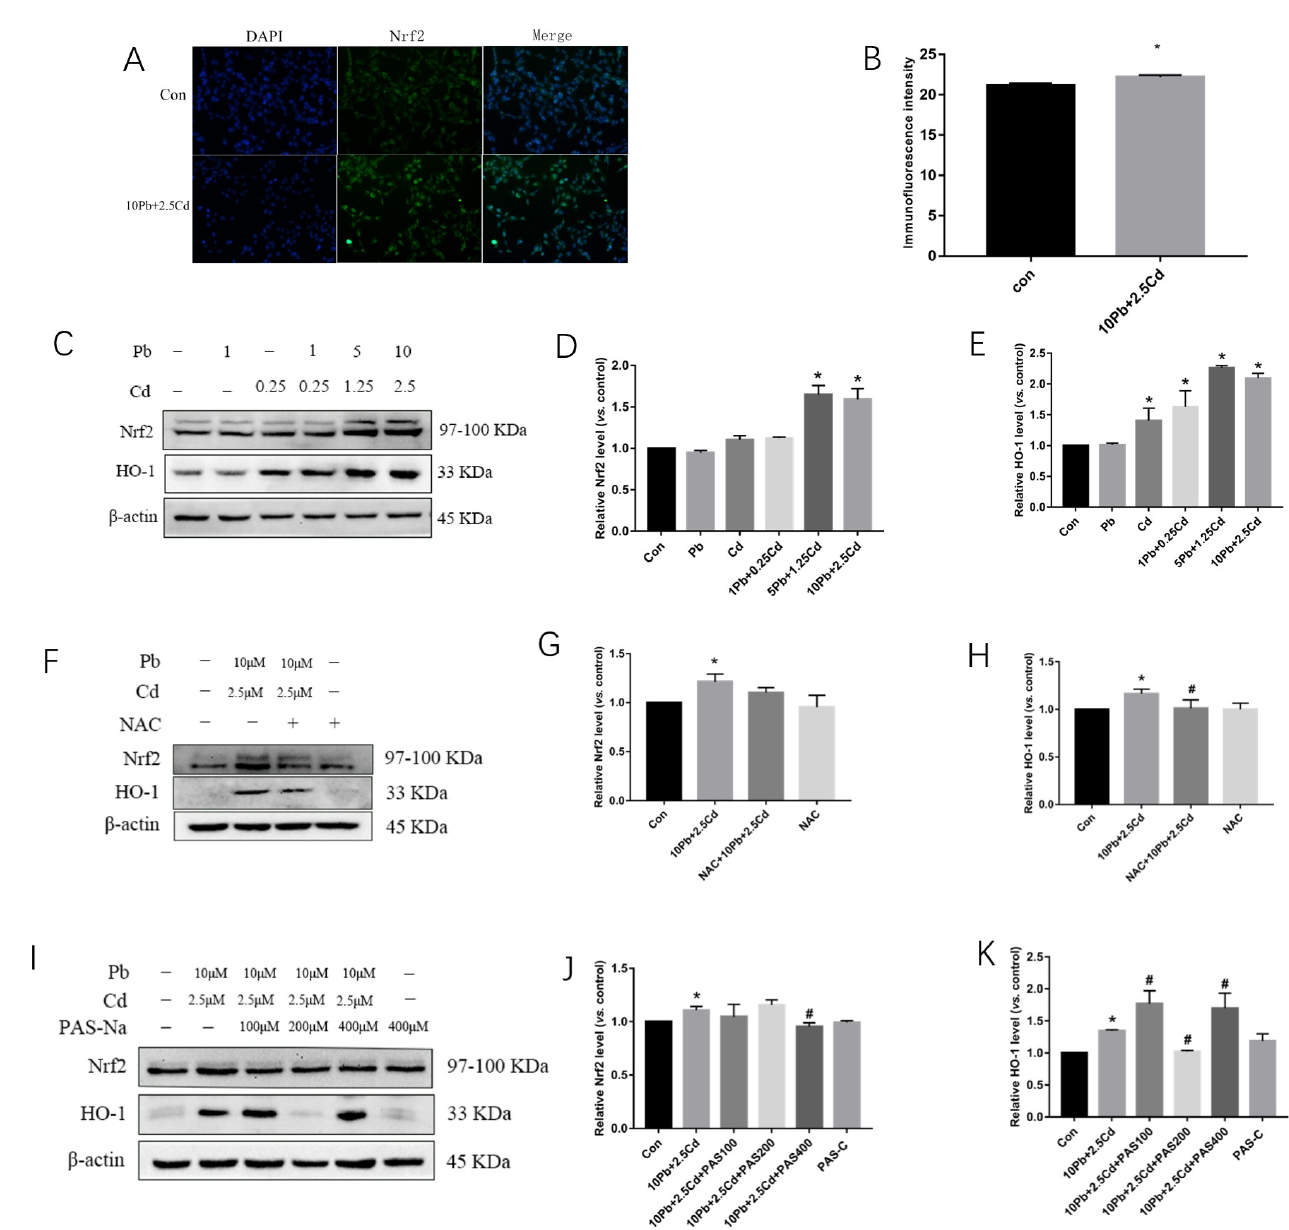
Figure 4. Effects of lead and cadmium exposure alone or in combination on Nrf2/HO-1 in SH-SY5Y cells. Additionally, the effect of NAC and PAS-Na intervention on Nrf2 and HO-1 protein expression exposed to lead and cadmium. ( A ) Immunofluorescence staining showed the location of Nrf2 protein in basal ganglia after combined Pb-Cd exposure at 24 h. Scale bar = 20 μ m. ( B ) Immunofluorescence intensity in the control group and 10 Pb + 2.5 Cd group. ( C , F , I ) Western blot results; ( D , G , J ) Nrf2 expression; ( E , H , K ) HO-1 expression. An amount of 1 Pb is 1 μ mol/L Pb, and 0.25 Cd is 0.25 μ mol/L Cd. An amount of 1 Pb + 0.25 Cd is 1 μ mol/L Pb + 0.25 μ mol/L Cd mixture, 5 Pb + 1.25 Cd is 5 μ mol/L Pb + 1.25 μ mol/L Cd mixture, 10 Pb + 2.5 Cd is 10 μ mol/L Pb + 2.5 μ mol/L Cd mixture. *, p < 0.05 compared with the control. #, p < 0.05, compared with the 10 Pb + 2.5 Cd. Data are presented as mean ± SD.